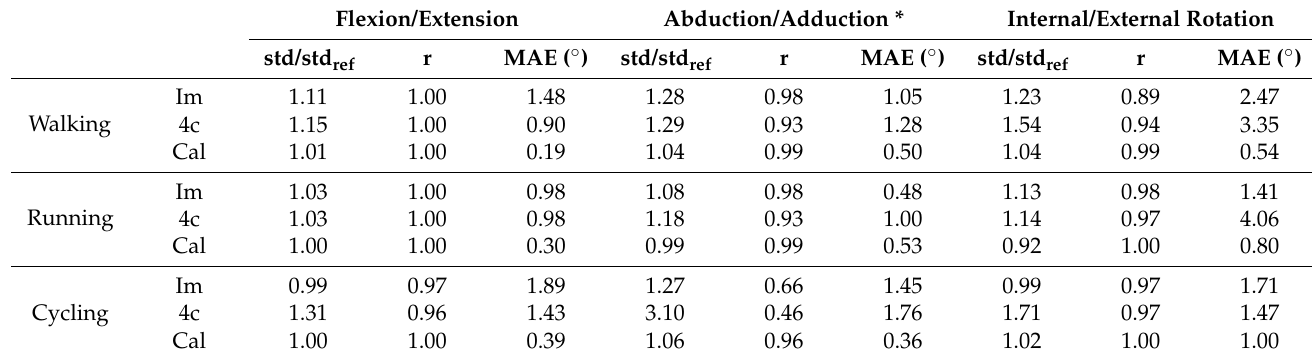
Table 5. Summary of angles statistics in the three rotation planes, averaged over all joints (n = 5, 3, 2 for Flexion/Extension, Abduction/Adduction, and Internal/External Rotation, respectively.). All conditions are represented: degraded image quality (Im), four cameras instead of eight (4c), and degraded calibration (Cal). These conditions were compared to the reference one (Ref) by calculating the ratio of standard deviation (std/std ref ), the Pearson’s correlation coefficient (r), and the mean absolute error (MAE). * Ankle subtalar angle is assimilated to an abduction/adduction